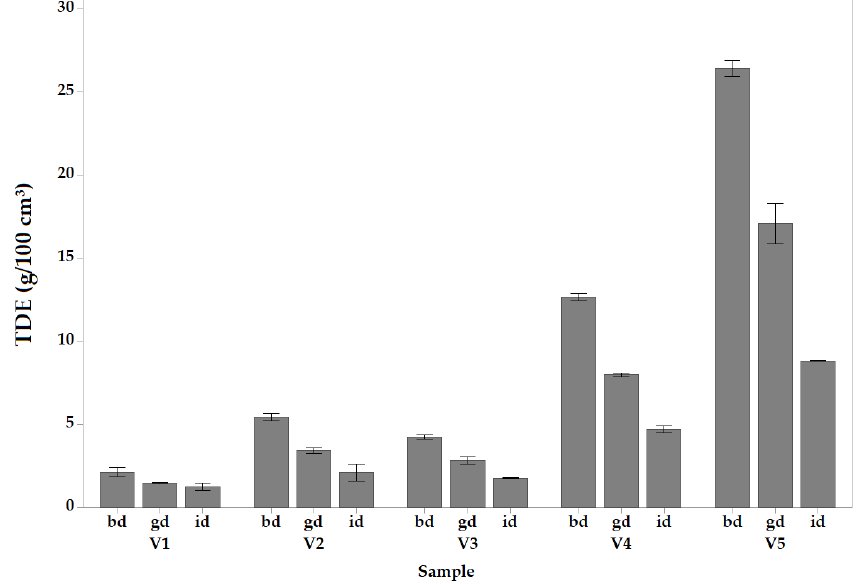
Figure 2. Interval plots of total dry extract (TDE) vs. samples before digestion (bd); and after gastric digestion (gd); intestinal digestion (id). V1 = banana peel vinegar aged for 1 year, produced without boiling the peels boiling aged for 1 year, V2 = banana peel vinegar aged for 3 years, produced without boiling the peels boiling aged for 3 years, V3 = banana peel vinegar aged for 2 years, produced with peels boiling the peels aged for 2 years, V4 = commercial balsamic vinegar produced from concentrated apple juice and caramel aged in oak barrels for 1 year, V5 = Modena commercial vinegar obtained from concentrated grape must. The error bars represent a 95% confidence interval for the mean.